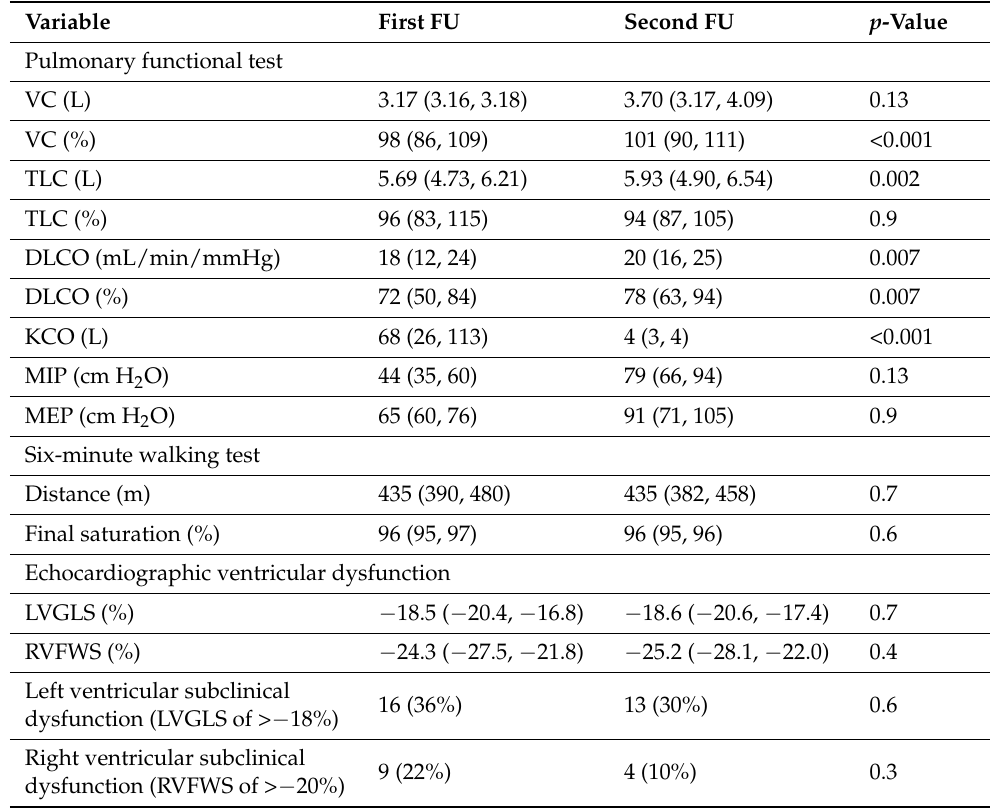
Table 6. Multi-parametric comparison (pulmonary functional test, 6MWT, and cardiac imaging data) between the two consecutive follow-up